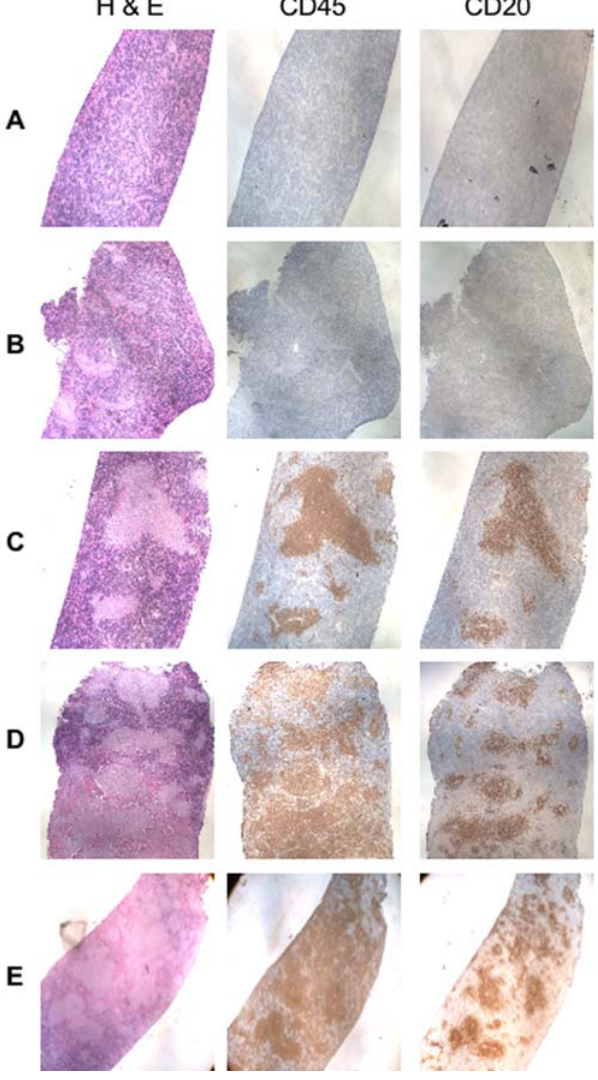
Figure 4. Immunohistology of in vivo PBL engraftment in NOD rag2 2 / 2 Prf1 2 / 2 mice. On day of sacrifice, day 21 post PBL transfer, spleens were harvested and fixed for immunohistological analysis of B and T cell engraftment. Sections were visualized and photographed using a nikon microscope. All images were taken at 20 6 magnification. Rows A and B are PBS treated mice; C from mice treated 7 days with BLyS and, D and E from mice treated for 14 days with BLyS (10 ug/ mouse/day). All mice were untreated days 14–21 prior to sacrifice. Serial sections were stained with hemotoxylin and eosin, anti-human CD45 or anti-human CD20. Data is representative of 6 experiments.